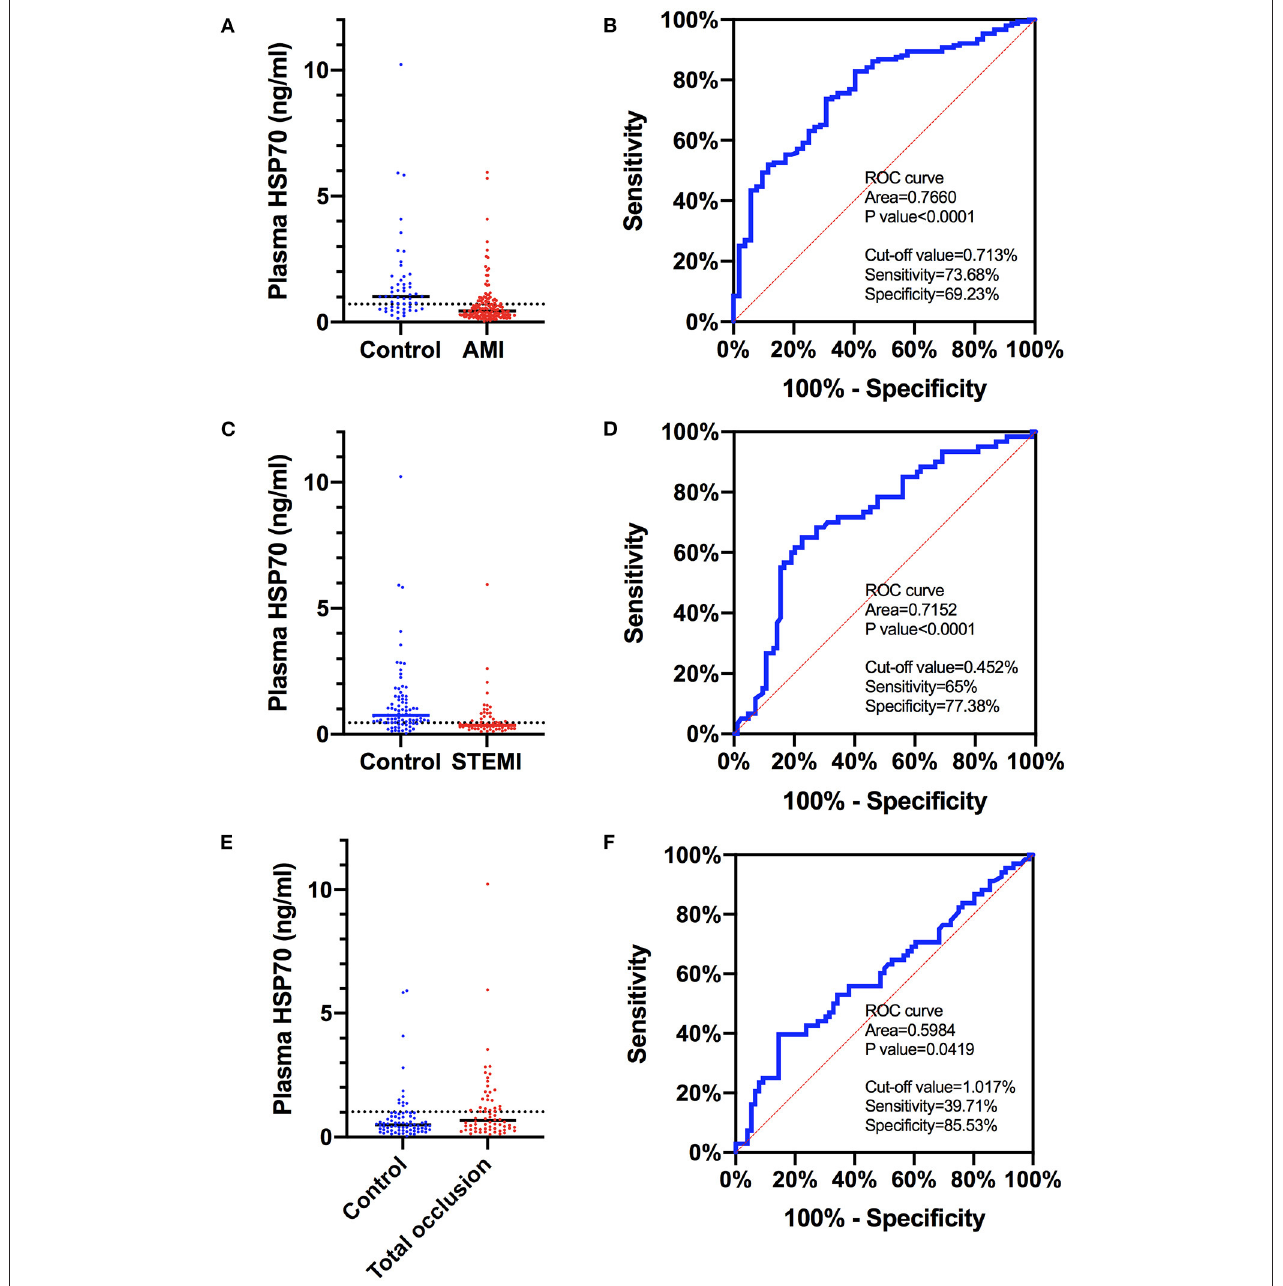
FIGURE 3 | ROC curves of plasma HSP70 to predict AMI, STEMI, and total occlusion in target lesions. (A) Comparison of plasma HSP70 in patients with AMI and control patients with no AMI; (B) ROC curves of HSP70 to predict AMI, with an AUC of 0.7660 (95% CI 0.6946–0.8374) and best cutoff value of 0.713ng/ml; (C) comparison of plasma HSP70 in patients with STEMI and control patients with no STEMI; (D) ROC curves of HSP70 to predict STEMI, with an AUC of 0.7152 (95% CI 0.6289–0.8015) and best cutoff value of 0.452ng/ml; (E) comparison of plasma HSP70 in patients with total occlusion and control patients with no total occlusion; (F) ROC curves of HSP70 to predict total occlusion, with an AUC of 0.5984 (95% CI 0.5048–0.6920) and best cutoff value of 1.017ng/ml. AMI, acute myocardial infarction; STEMI, ST-segment elevation myocardial infarction; ROC, receiver operating characteristic; AUC, area under the curve.